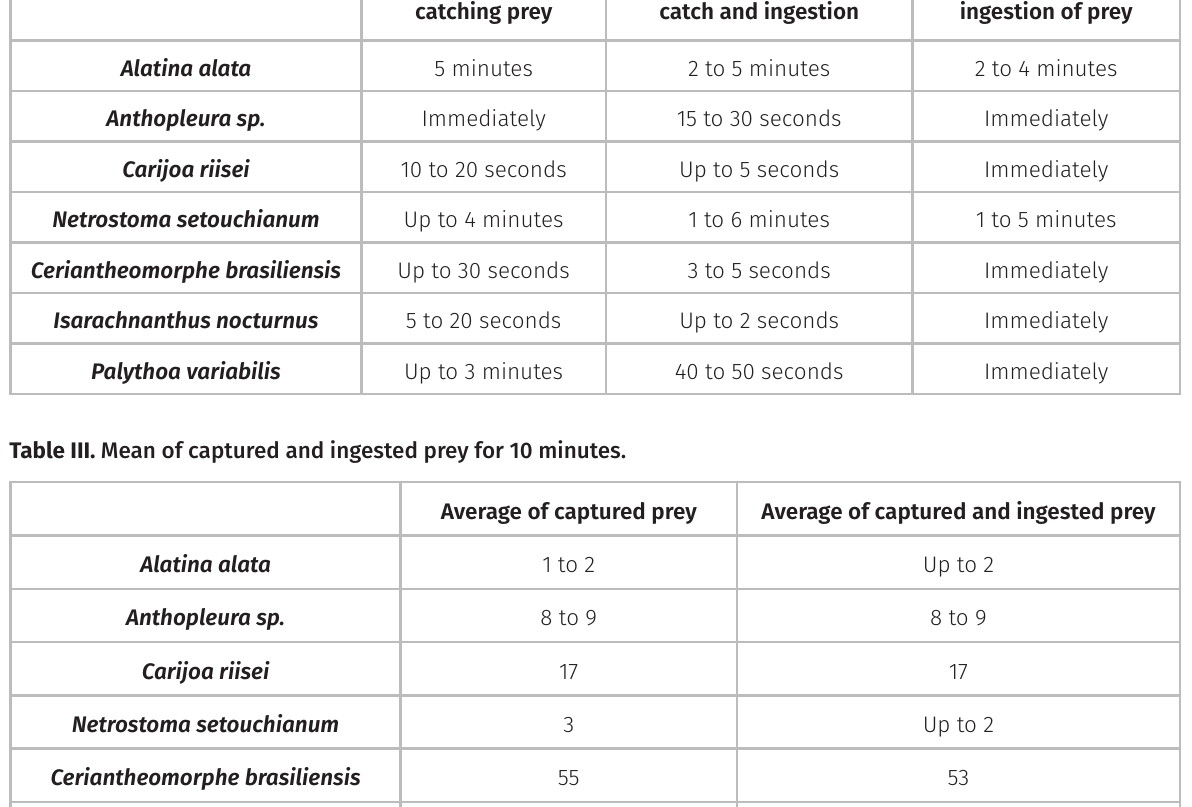
Table II. Observation of the feeding behavior to the different groups of cnidarians. Average time to start catching prey